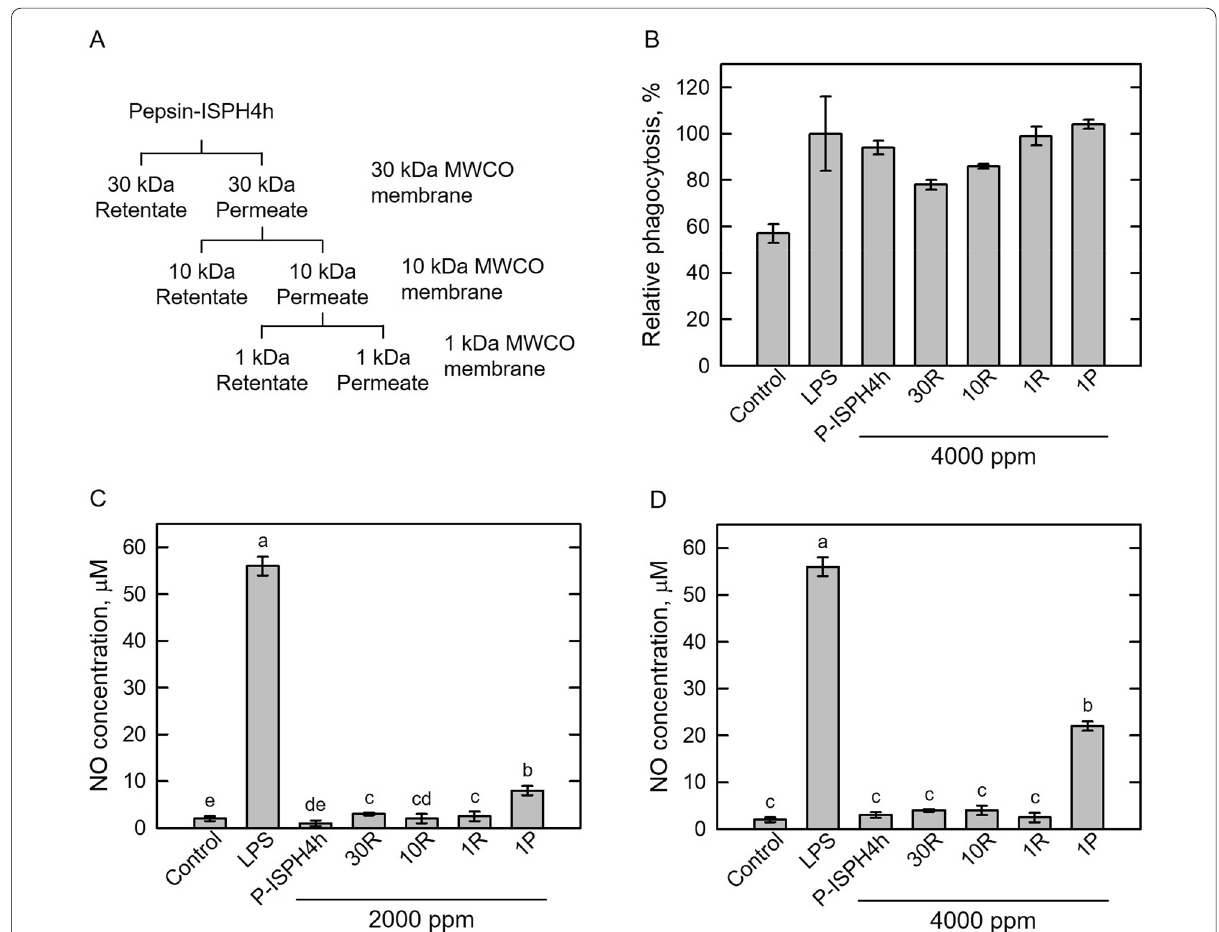
Fig. 2 Fractionation of Pepsin‑ISPH by molecular weight cut‑off (MWCO) membrane. A fraction chart. B effect of 4000 ppm Pepsin‑ISPH and its retentates/permeate on relative phagocytosis (%) in mouse macrophage RAW246.7 cells. Dosage effect of Pepsin‑ISPH and its retentates/permeate, 2000 ppm ( C ) and 4000 ppm ( D ) on NO concentration in mouse macrophage RAW246.7 cells. LPS (1 ppm) was used as positive control. Bars represent mean standard deviation (SD; n 3). Mean with different letters are significantly different ( p < 0.05) by Duncan’s multiple range ± =